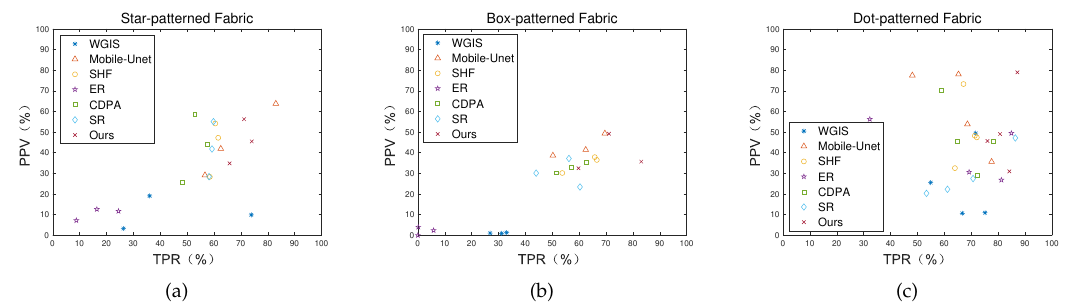
Figure 16. TPR-PPV scatter plots for ( a ) star-pattern, ( b ) box-pattern and ( c )